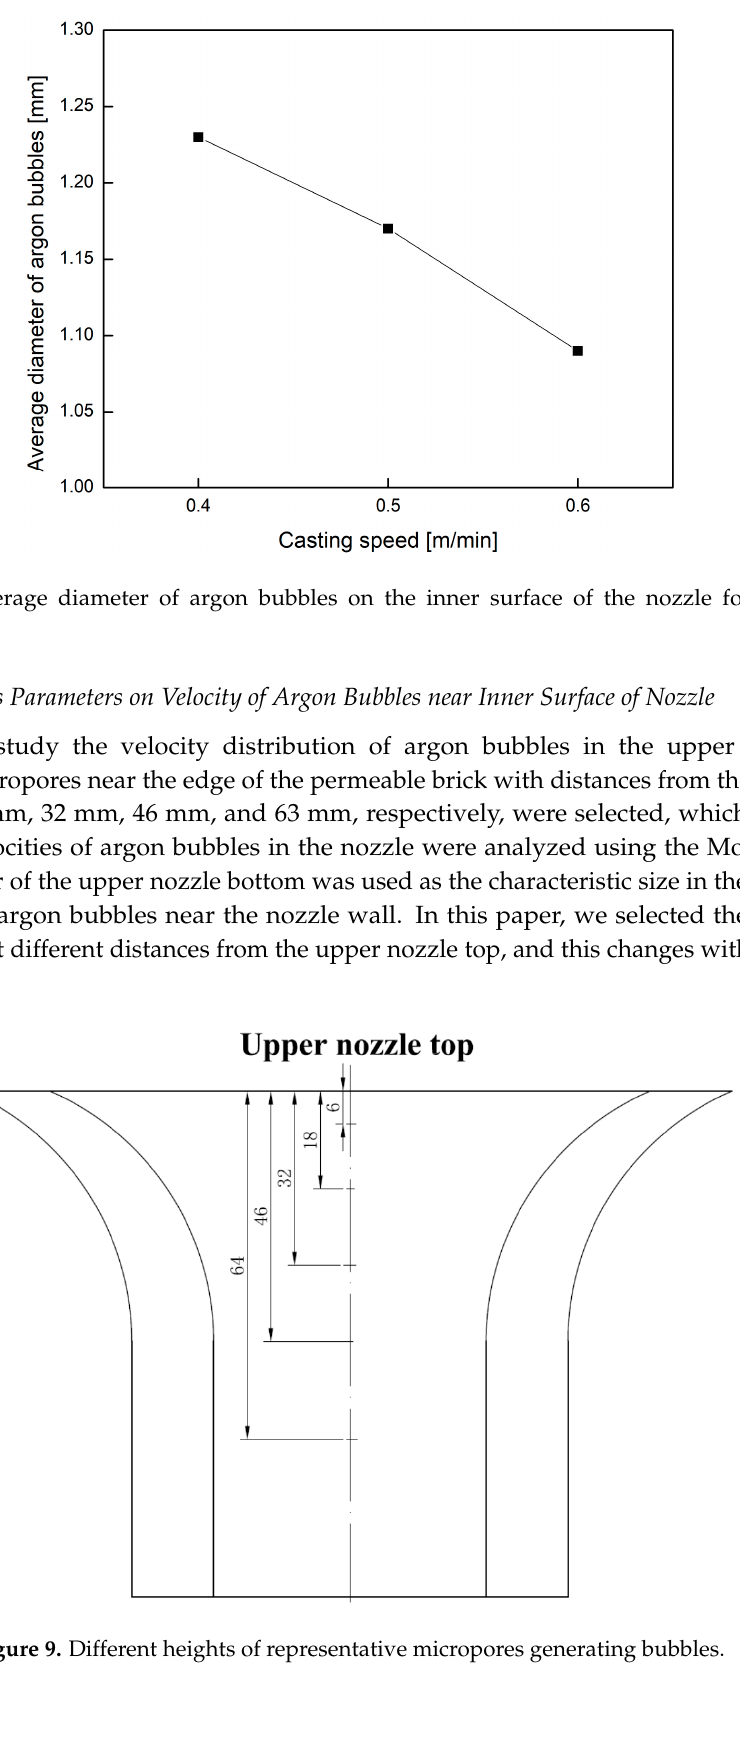
Figure 9. Different heights of representative micropores generating bubbles.